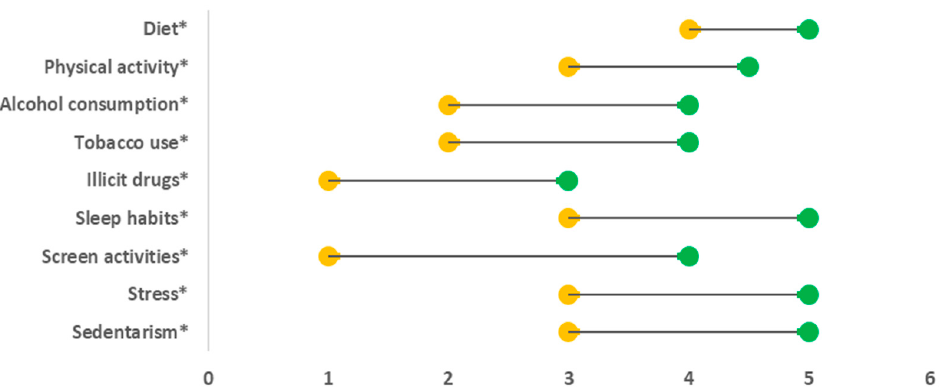
Figure 2. The differences between level of importance given to the family doctor to address health behaviors (dimension 3) and the reported approach implemented by the family doctor (dimension 4) for each lifestyle intervention. (*) Significant at 5% (Wilcoxon test with Bonferroni adjustment). Yellow = median value of the variable if, in the personal case, something was usual or not, the family doctor asks/advises. Green = median value of the variable level of importance given to the family doctor to address. Note: a higher value is better than a lower value.